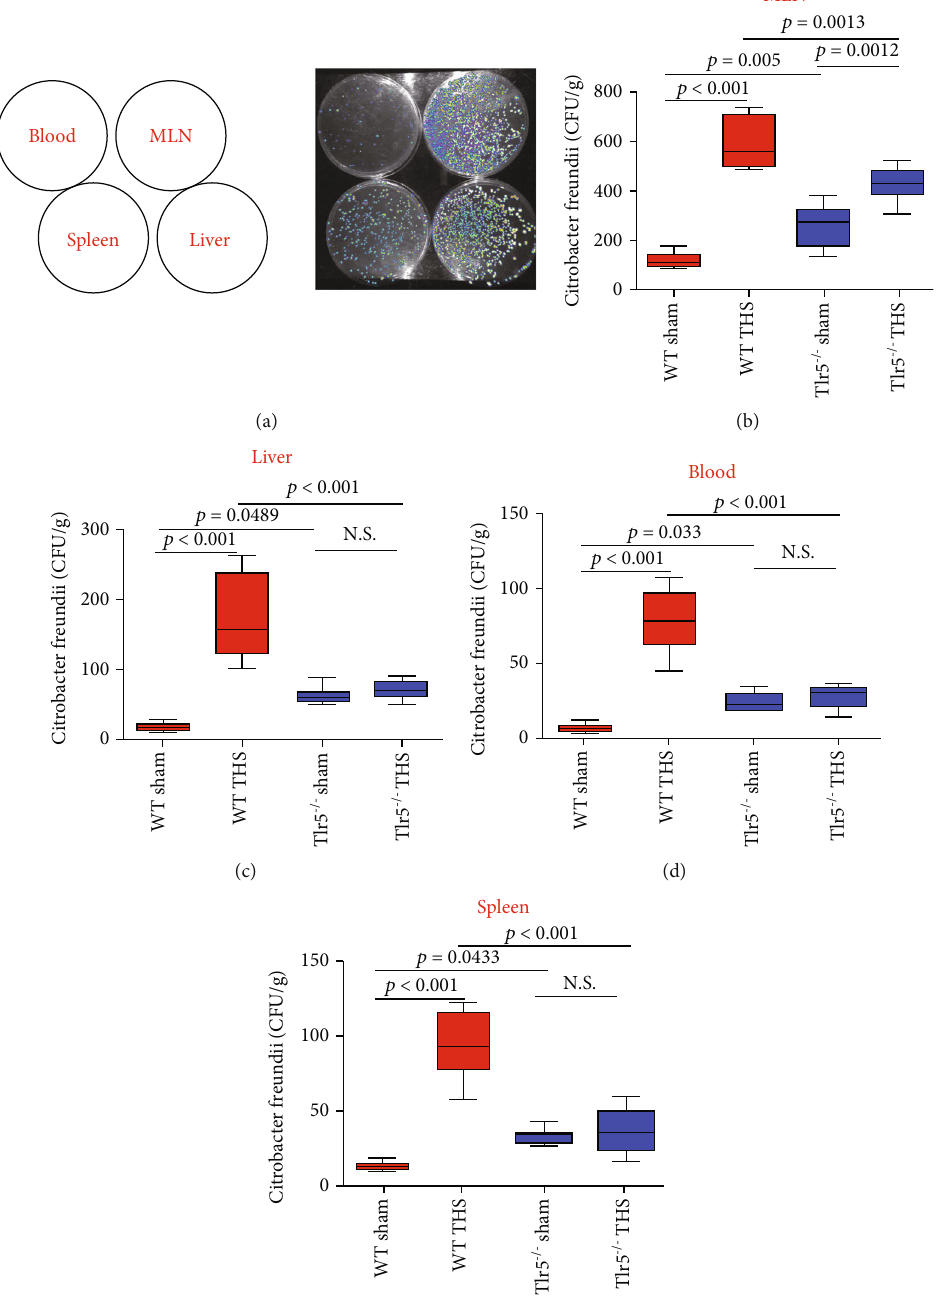
Figure 1: E ff ect of TLR5 de fi ciency on the translocation and dissemination of commensal bacteria. Bioluminescent C. rodentium , visualized using an in vivo imaging system (IVIS), was used to monitor bacterial translocation. (a) The panel of LB agar plates with di ff erent tissue homogenates was shown in the top left corner. Sham-operated mice or mice 48 hours after THS were inoculated by oral gavage with C. rodentium and sacri fi ced approximately 5 hours after the challenge. After that, sample homogenates obtained from the MLNs (b), liver (c), blood (d), and spleen (e) were plated on LB agar culture plates and grown under aerobic condition at 37 ° C for 12 hours. Subsequently, bacterial CFUs were visualized (a) using IVIS, and bacterial abundance was calculated (b – e). Boxes represent the interquartile range (bottom, 25 th percentile; top, 75 th percentile), and the line inside represents the median. Whiskers denote the lowest and highest values within 1.5x the interquartile range. Each group contained 8 animals. N.S. indicates not signi fi cant. All signi fi cant p values are marked, and p < 0 : 05 is considered signi fi cant by one-way ANOVA test. Data are representative of three independent